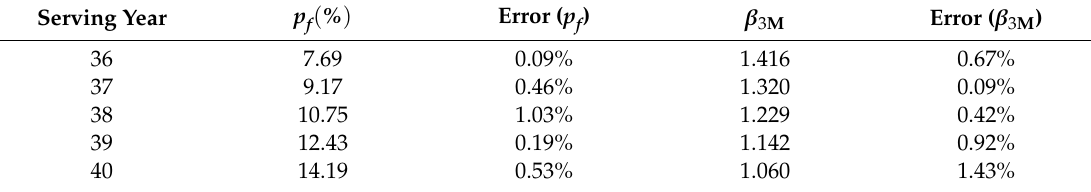
Figure 16. Time-varying reliability index and MC simulation ( f c = 18.0 N/mm 2 ). Table 3. Part of failure probabilities and reliability indices from 36 to 40